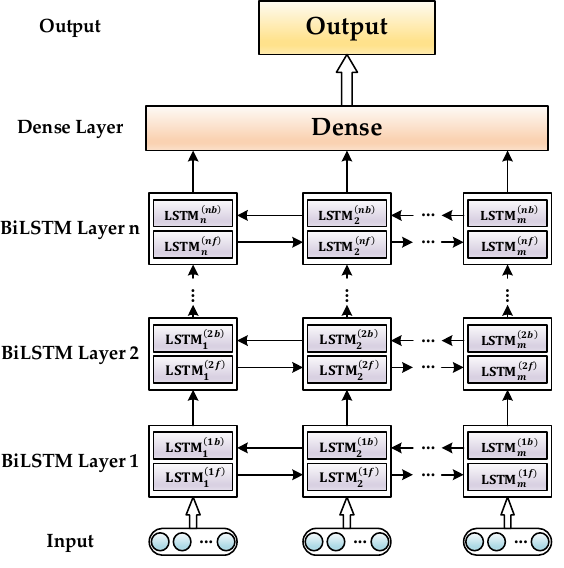
Figure 5. Multi-layer BiLSTM network.